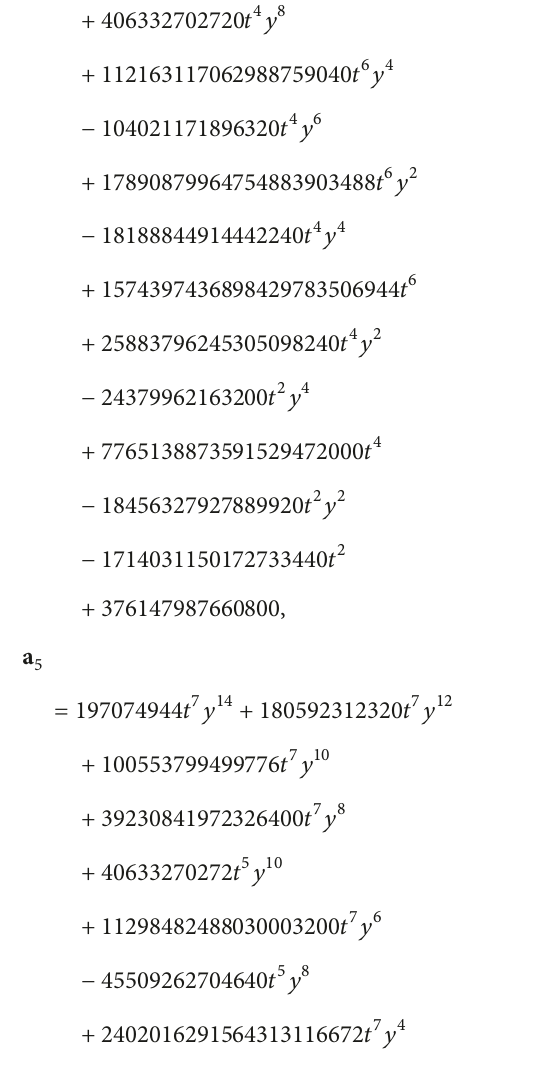
= 10 5 , 𝑏 = 10 3 , 𝑎 = 0 , and 𝑏 = 0 . 1 1 2 2